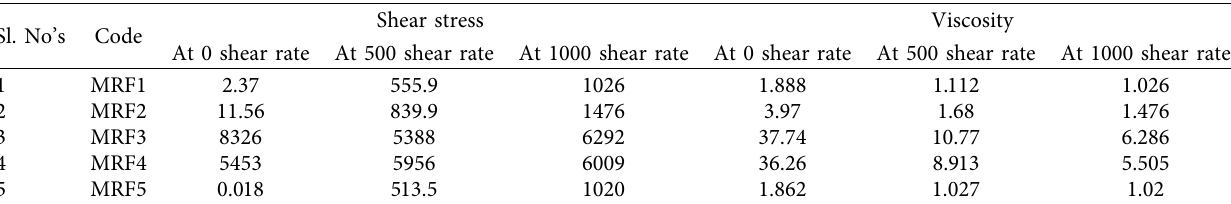
Figure 6: Shear rate vs. viscosity for MRFs. Table 2: Rheological properties of synthesized